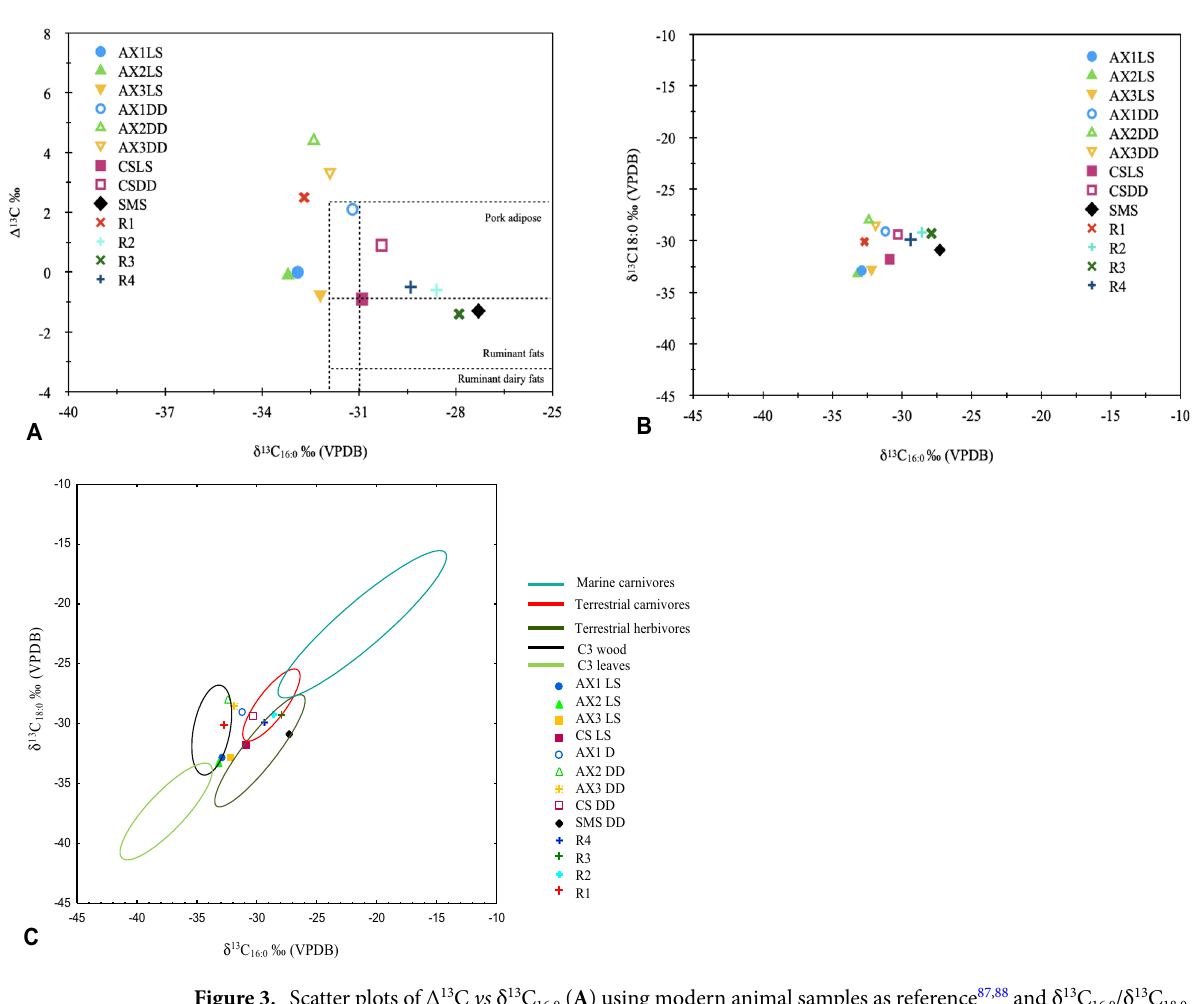
Figure 3. Scatter plots of ∆ 13 C vs δ 13 C 16:0 ( A ) using modern animal samples as reference 87,88 and δ 13 C 16:0 /δ 13 C 18:0 ratios ( B ) and comparison with 95% confidence ellipses plotted using published data on isotopic ratios for C3 leaves and wood, terrestrial herbivores and carnivores and marine carnivores ( C ) 21,22,65,67,69–71,89